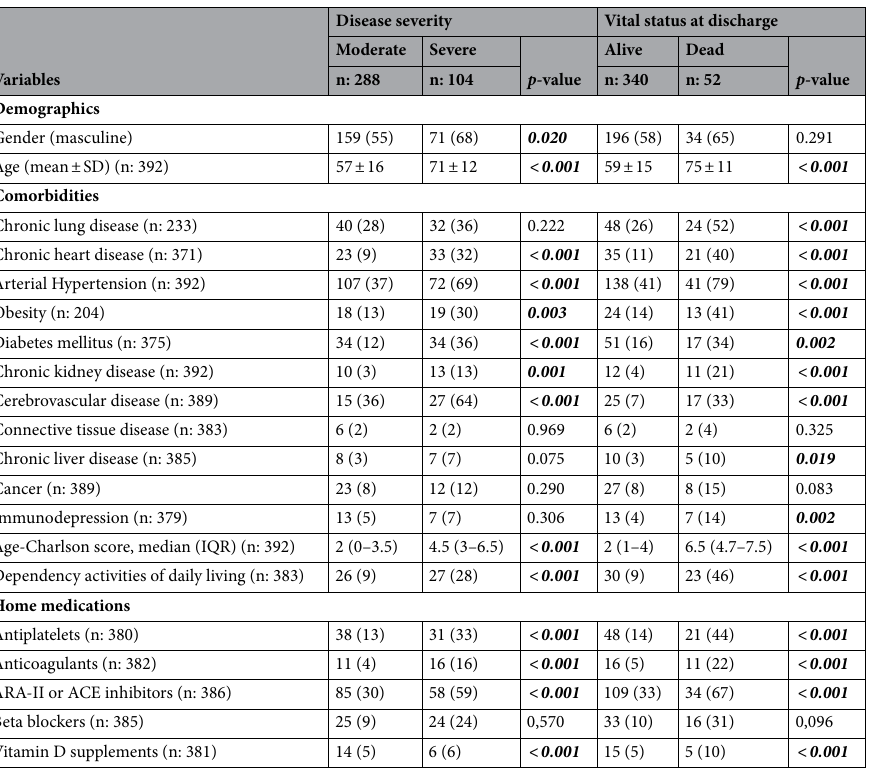
Table 1. Baseline characteristics and home medication, according to the development of severe disease and vital status at discharge. ARA: angiotensin II receptor antagonists. ACEi: angiotensin-converting enzyme inhibitor. In each variable, total number of valid data is specified in the first column. In each outcome, absolute frequency, percentage by outcome and p-values for the comparation of moderate vs severe disease and alive vs dead at discharge are shown. In bold and italic those associations that are statistically significant. IQR: interquartile range; SD: standard